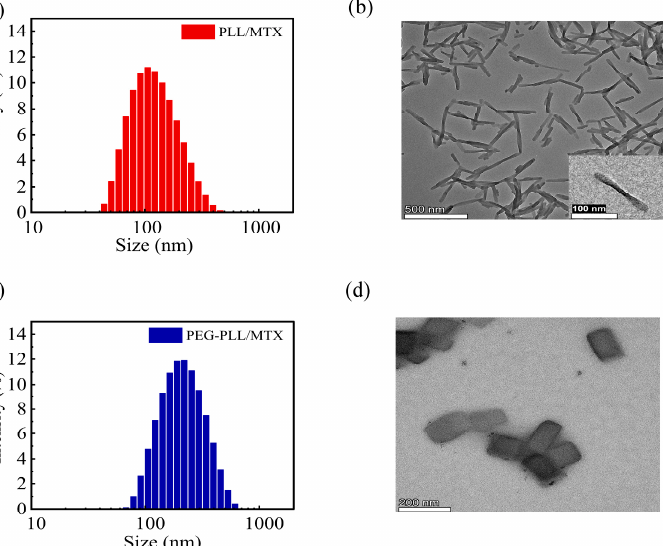
Figure 1. The DLC curve of PLL/MTX NPs ( a ), PEG-PLL/MTX NPs ( c ), and TEM image of PLL/MTX NPs (( b ), Scale bar: 500 nm. insert, Scale bar: 100 nm), PEG-PLL/MTX NPs (( d ), Scale bar: 200 nm).